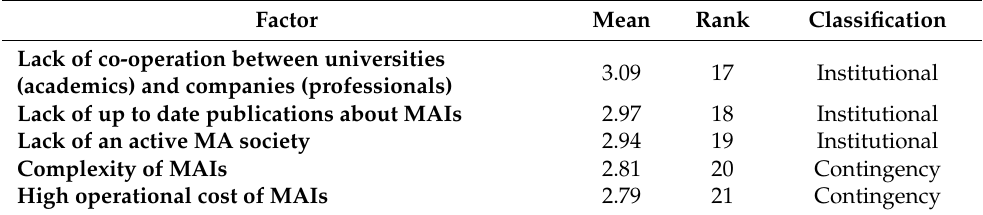
Table 21. The factors with the lowest influence in terms of hindering the adoption of MAIs Factor Mean Rank Classification Lack of co-operation between universities 3.09 17 Institutional (academics) and companies (professionals) Lack of up to date publications about MAIs 2.97 18 Institutional Lack of an active MA society 2.94 19 Institutional Complexity of MAIs 2.81 20 Contingency High operational cost of MAIs 2.79 21